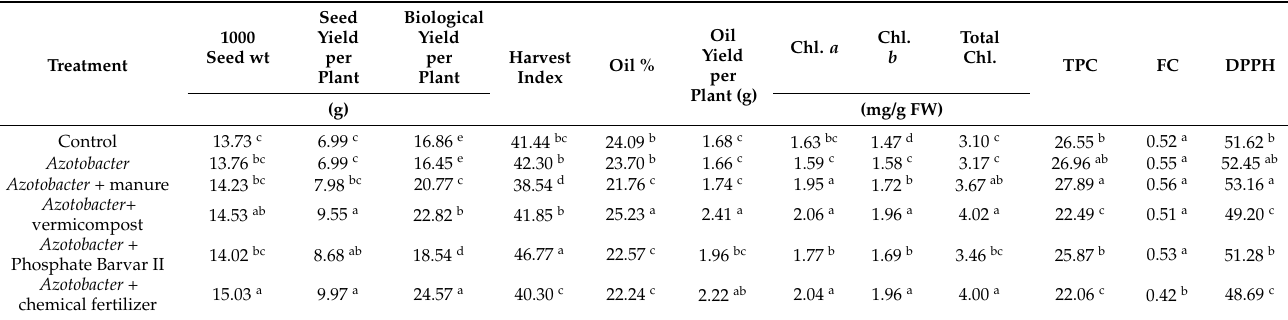
Table 2. Means comparison for the quantitative and qualitative traits of Syrian cephalaria as influenced by organic and chemical